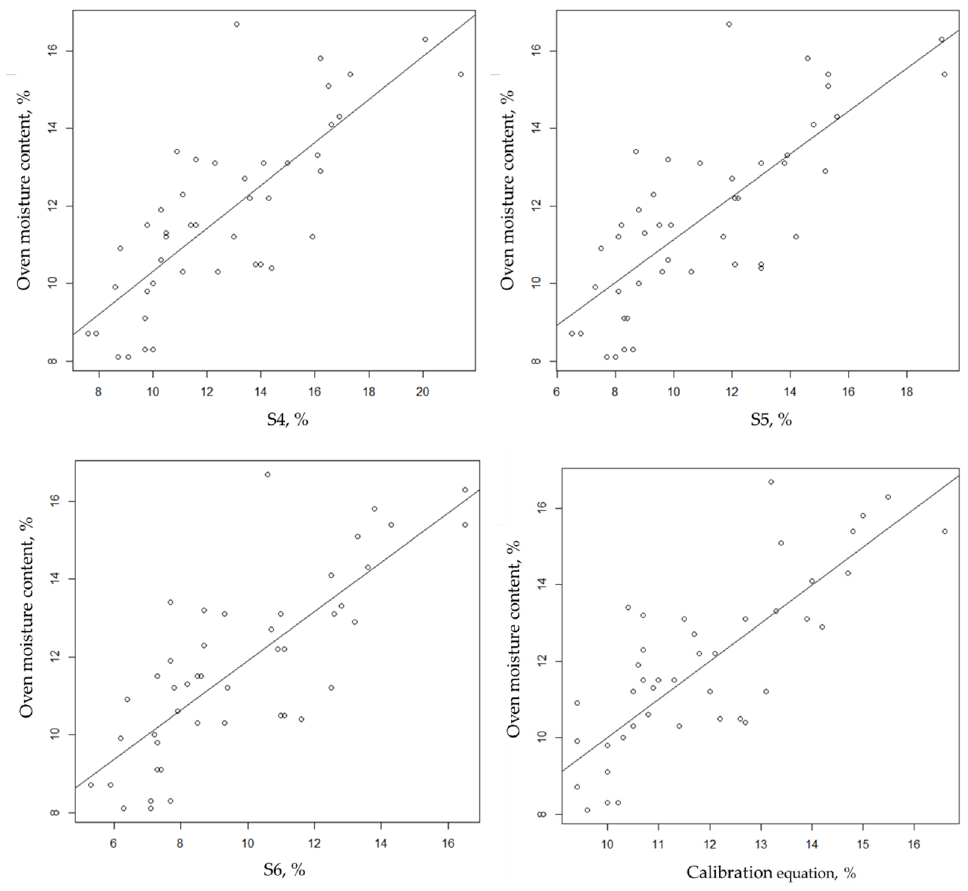
Figure 5. Linear regression of the preinstalled programs of the equipment (S4, S5 and S6) versus the oven moisture (OM